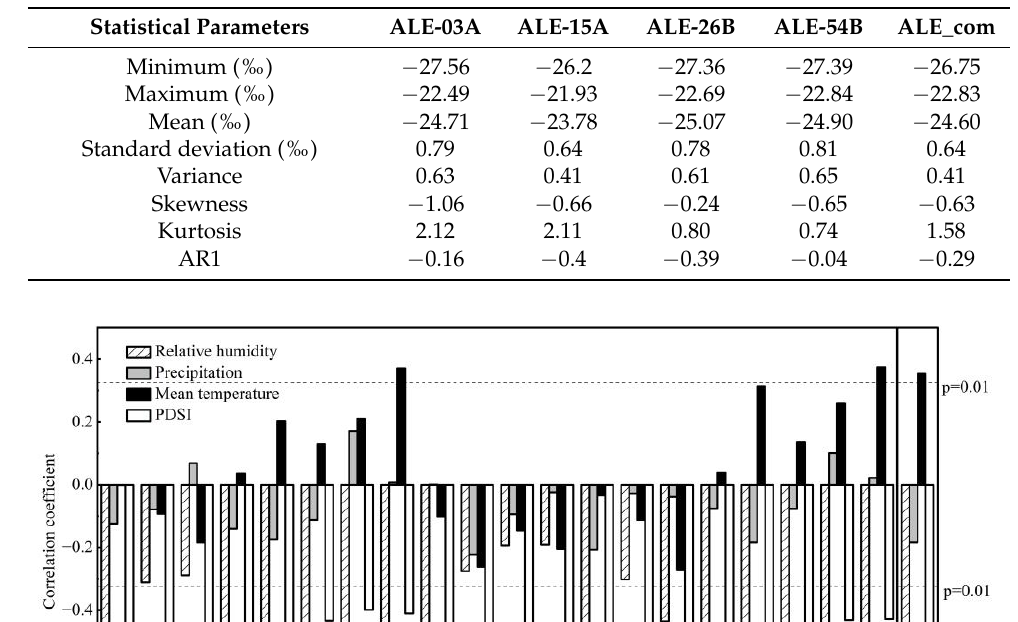
Figure 3. The δ 13 C pin series in Alaer. ( a ) The δ 13 C pin data of the four cores. ( b ) The master δ 13 C pin series produced by averaging the four z-scored individual series. ( c ) The mean inter-series correlation (Rbar) and the running EPS were calculated using 30-year windows and a lag time of 15 years. Table 2. Statistical characteristics of the individual tree-ring δ 13 C pin series of Alaer.